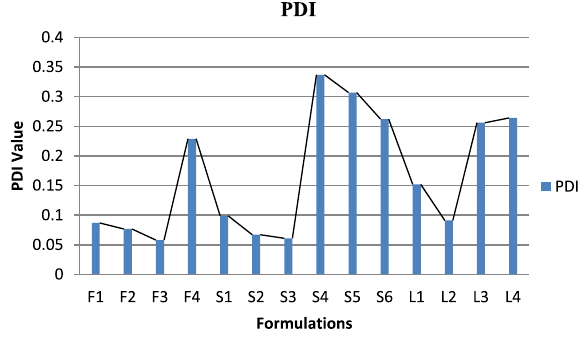
Figure 3. Graphical representation of PDI of Glu-loaded formulations.